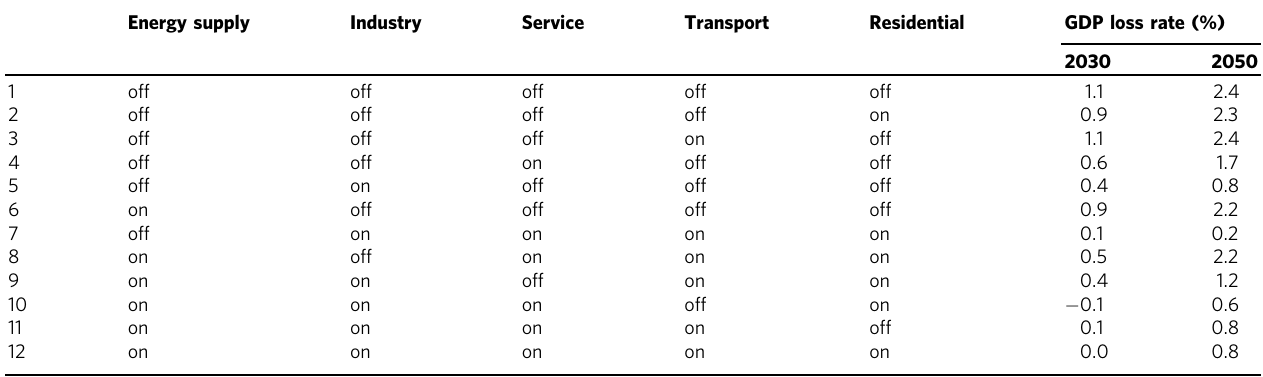
Column names are sectors, and on and off refer to whether AIM/Enduse information is incorporated. The red and blue rows indicate the stand-alone and integrated models, respectively. Yellow and green rows indicate scenarios that include and exclude information from a single sector given by AIM/Enduse, respectively